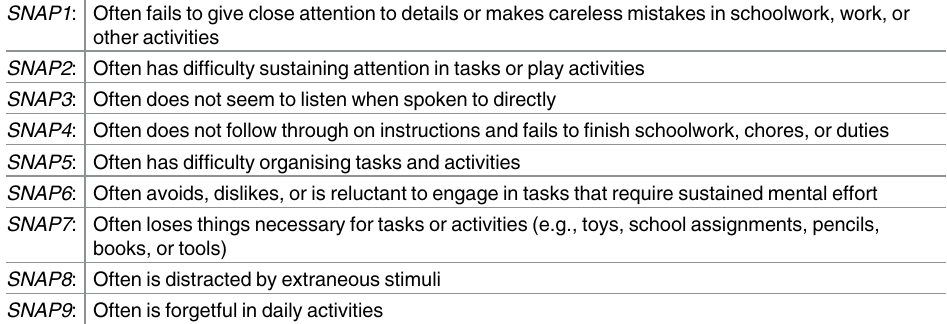
Table 1. SNAP items, scored as “not true” (0), “somewhat true” (1), and “certainly true” (2). SNAP1 : Often fails to give close attention to details or makes careless mistakes in schoolwork, work, or other activities SNAP2 : Often has difficulty sustaining attention in tasks or play activities SNAP3 : Often does not seem to listen when spoken to directly SNAP4 : Often does not follow through on instructions and fails to finish schoolwork, chores, or duties SNAP5 : Often has difficulty organising tasks and activities